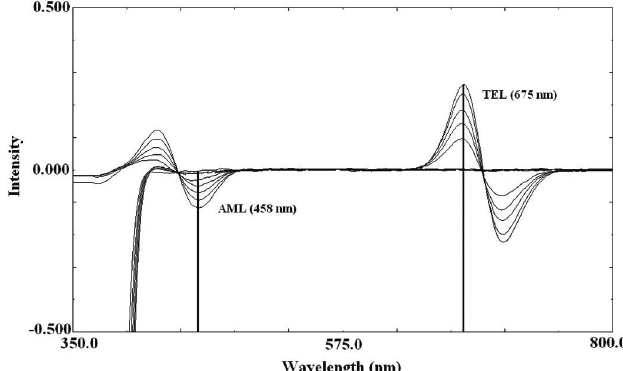
FIGURE 7 - First derivative synchronous linearity spectrum of amlodipine besylate (AML) and telmisartan